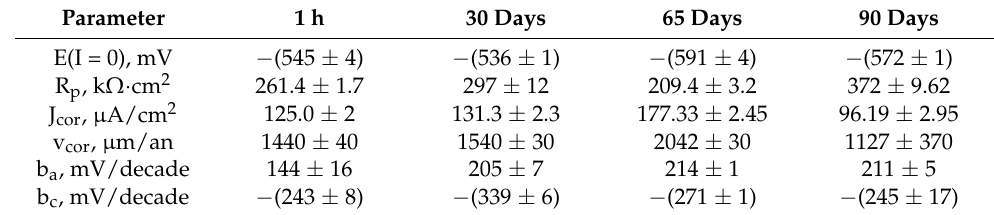
Table 4. Instantaneous corrosion process parameters for samples immersed in DWW-2.